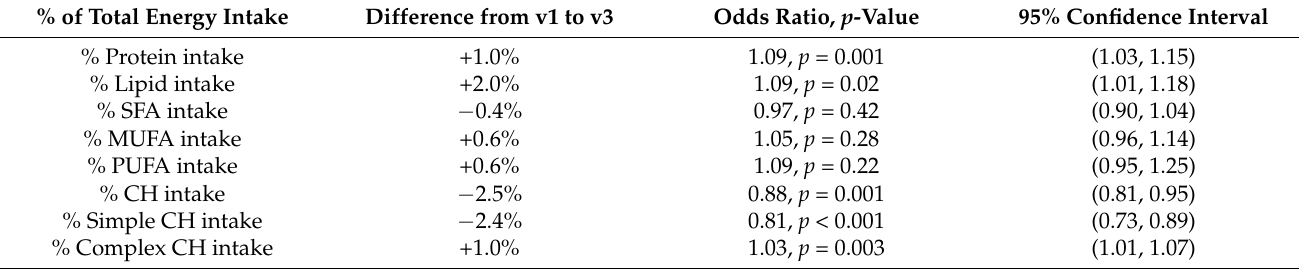
Figure 2. Changes in macronutrient intake during the 6-months period of use of the self-management mobile app in the study cohort ( n = 84): ( a ) protein, ( b ) carbohydrate and ( c ) lipids. Grey areas represent the range of the recommended intake according to Turk et al. (2016) [3]. According to the WHO guidelines, simple CH (sugar) intake should not be higher than 5% energy intake, and SFA should not exceed 10%. * statistically significant change ( p < 0.05) between visit in month 0 (v1) and month 6 (v3). Original to this manuscript). Table 1. Change in macronutrient contribution (% of total daily energy intake) after the 6-month intervention with the self-management mobile